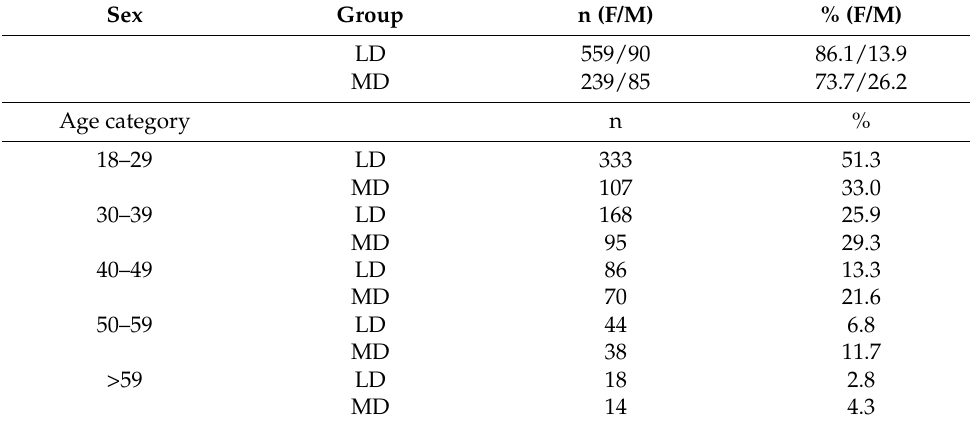
Table 2. Sex and age range of